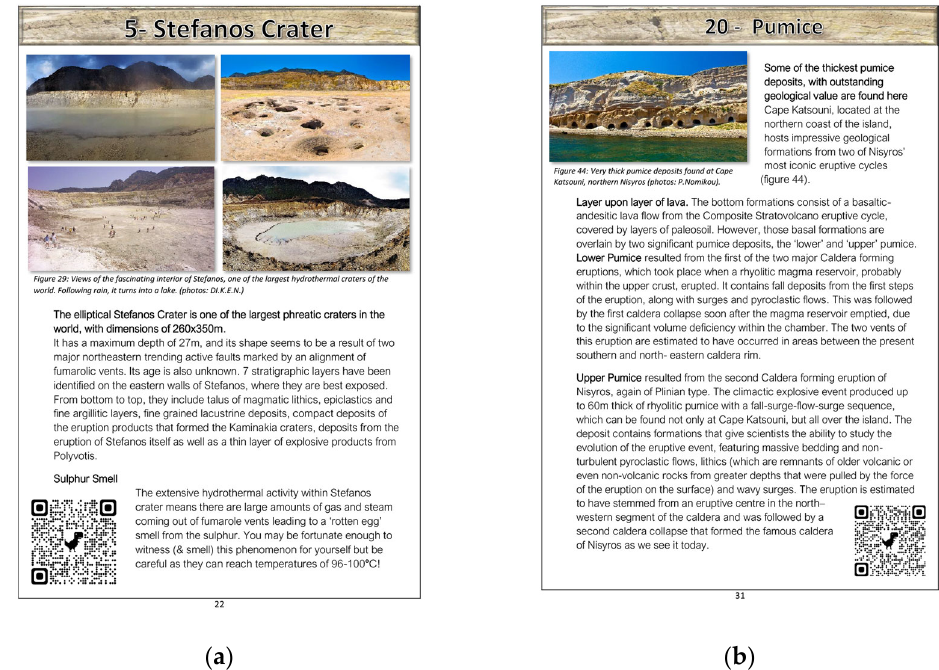
Figure 17. Examples of the content of the guidebook, regarding the detailed presentation of the ge ‐ osites. Each description is accompanied by images and a geologically styled QR code that links to the website: ( a ) Description of Stefanos Crater (Geosite 5); ( b ) Description of Pumice outcrops at northern Nisyros (Geosite 20).